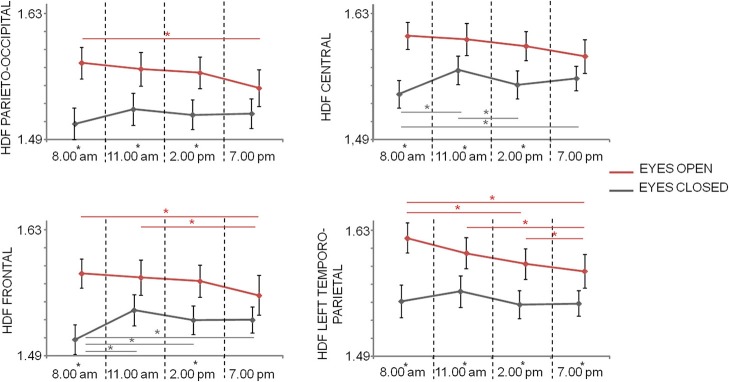
Mean and standard error of HFD values in the different regions at the 4 times in closed eyes (gray) and open eyes (red) conditions. Significances of the paired t-test between times are shown (gray for closed eyes and red for open eyes; *p < 0.05, FDR corrected). The difference between eyes closed and eyes open conditions at one time is evidenced by a star as apex of corresponding time.